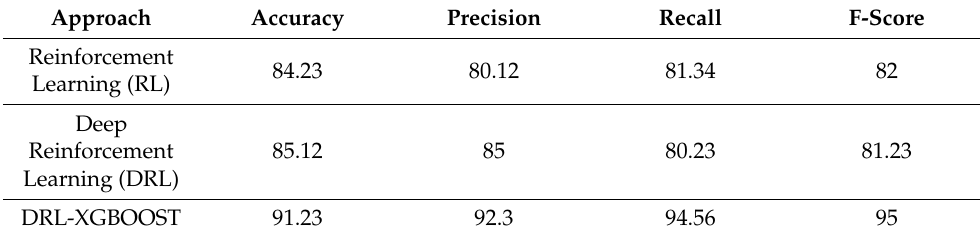
Table 6. OASIS dataset comparison.